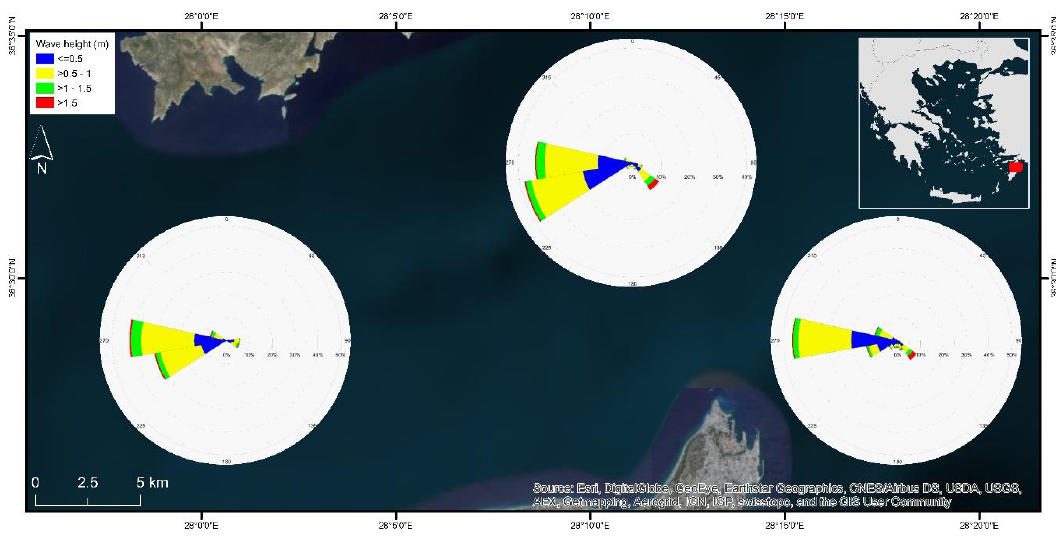
Figure 3. Rose diagrams offshore Rhodes Island, showing significant wave heights and mean wave directions, for the time period 1995–2004.